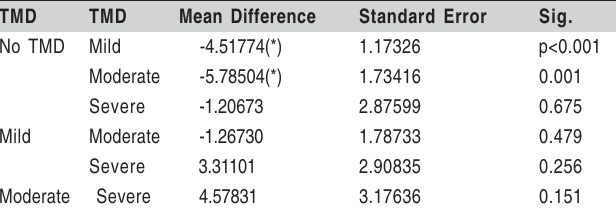
Table 3 . Significance between the differences in means for cervical angles in the different groups.